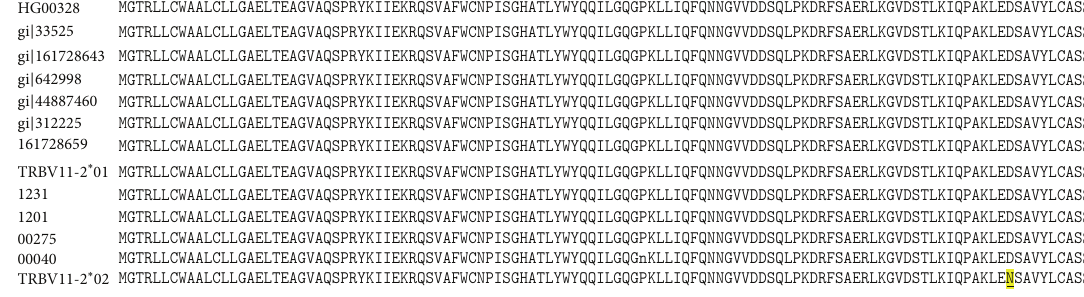
Figure 3: Genomic TRBV11-2 DNA sequences from Caucasian samples in the 1000 genomes database (including HG00328 (and HG00361, HG00320, HG00111, HG00310, HG00247, HG00256, HG00231, HG00127, HG00103, HG00117, HG0032, not shown)), five expressed sequences from the dbEST (indicated with gi numbers), two alleles of TRBV11-2 from IMGT, and four of the sequences we obtained at Drexel (1231, 1201, 00275, 00040) were translated and compared. Only TRBV11-2 ∗ 02 shows any nonsynonymous change (D105N, underlined, yellow highlight), and it is substantiated by one transcript (M33235). The D105N change (which is residue 98 using IMGT numbering) forms a salt bridge with a positive residue (Arg75) in the V 𝛽 domain but is away from the pMHC (see Supplementary Figure 1 available online at http://dx.doi.org//10.1155/2013/737485). Accordingly there could be some functional/structural consequence of that SNP, but given its location (not in any CDR region) and conservative nature (Asp to Asn) it is unlikely that this is a functionally significant change. There is, however,